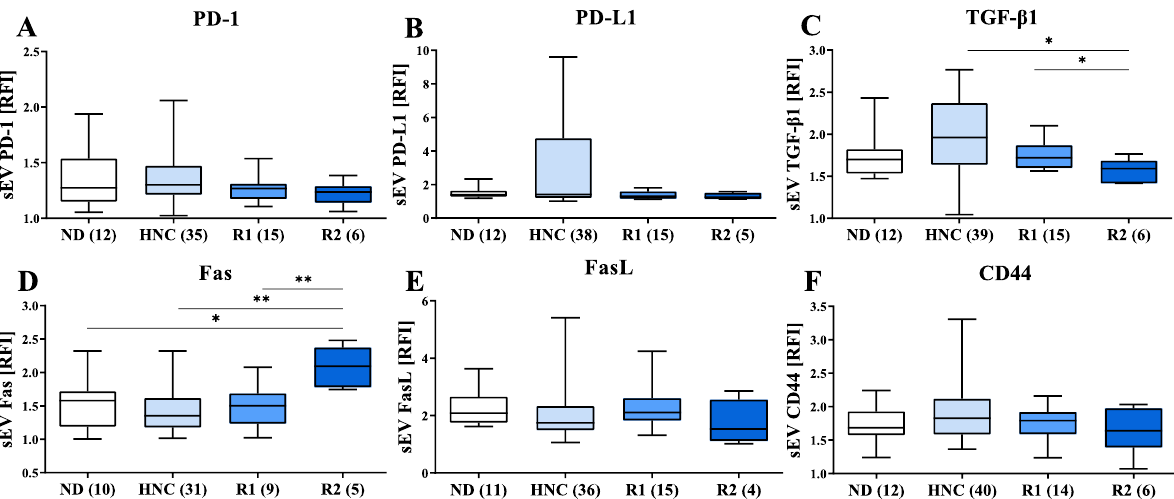
Figure 4. Expression of immunosuppressive markers on sEVs during follow-up. sEVs were captured on CD63-coated streptavidin beads and stained for immunosuppressive proteins on sEVs prepared from HNC patients and during follow-up period: after 3 (R1) and 6 (R2) months after tumor therapy. ( A – C ) PD-1, PD-L1 and TGF- β 1 expression levels on plasma sEVs decrease during follow-up. ( D ) Fas expression is upregulated at 6 months follow-up. ( E , F ) FasL and CD44 expression on sEVs are stable during follow-up. p values below 0.05 were considered significant (* p < 0.05, ** p < 0.01).